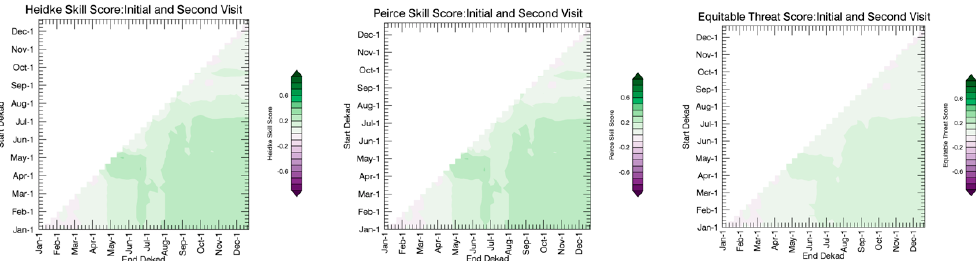
Figure 6. Histogram of Farmer-reported “bad years” for 21 villages in Tigray; combined visits.